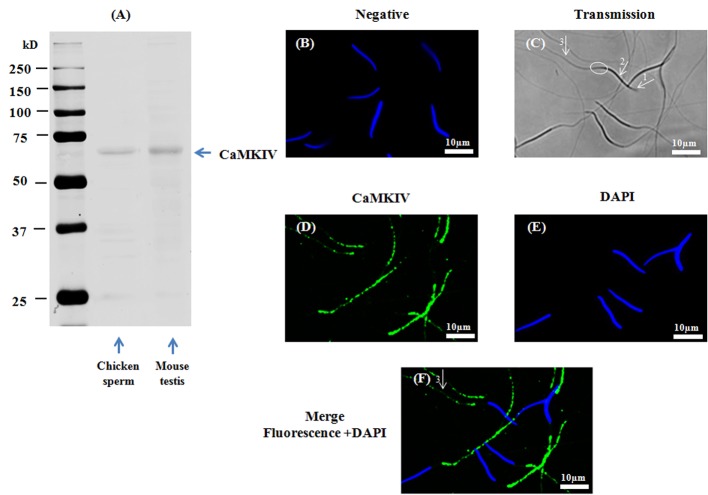
Presence and localization of CaMKIV in chicken sperm.Chicken sperm lysates (45μg of protein) were analyzed by western blotting using anti- CaMKIV as primary antibody. Cell lysates from mouse testis (40μg of protein) are used as positive control. A band of approximately 60kDa for CaMKIV was detected (4A). Indirect immunofluorescence of chicken sperm was carried out with the same antibody. Negative control: primary antibody was not added (4B). White arrows and circles in transmission images indicate areas of the acrosome (arrow 1), the nuclei (arrow 2), the midpiece (circles), and the principal piece of the flagellum (arrow 3) in sperm (4C). Immunofluorescence staining of CaMKIV (4D, green) was conducted; nuclei were stained with DAPI (4E, blue). Merged images of fluorescence with DAPI staining are shown in Fig 4F (white arrows indicate regions containing CaMKIV immunoreactivity: arrow 3: principle piece). Scale bar: 10μm.